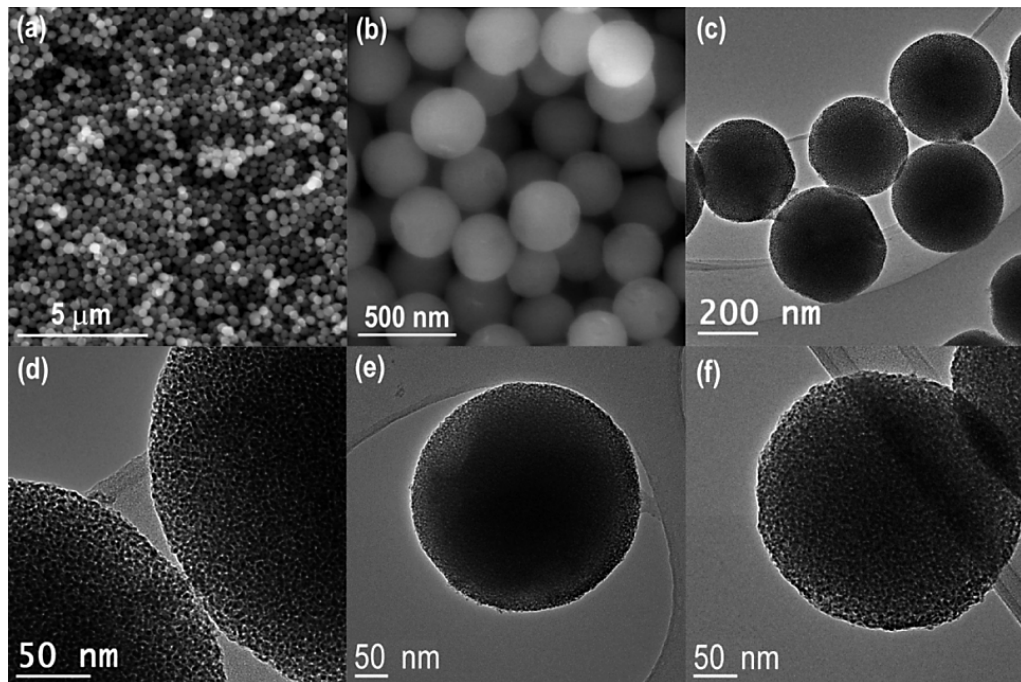
Figure 15. ( a , b ) SEM and ( c , d ) TEM images of the mesoporous TiZr30 nanospheres, and TEM images of the ( e ) mesoporous TiZr50 and ( f ) TiZr70 nanospheres. Reprinted with permission from [157].